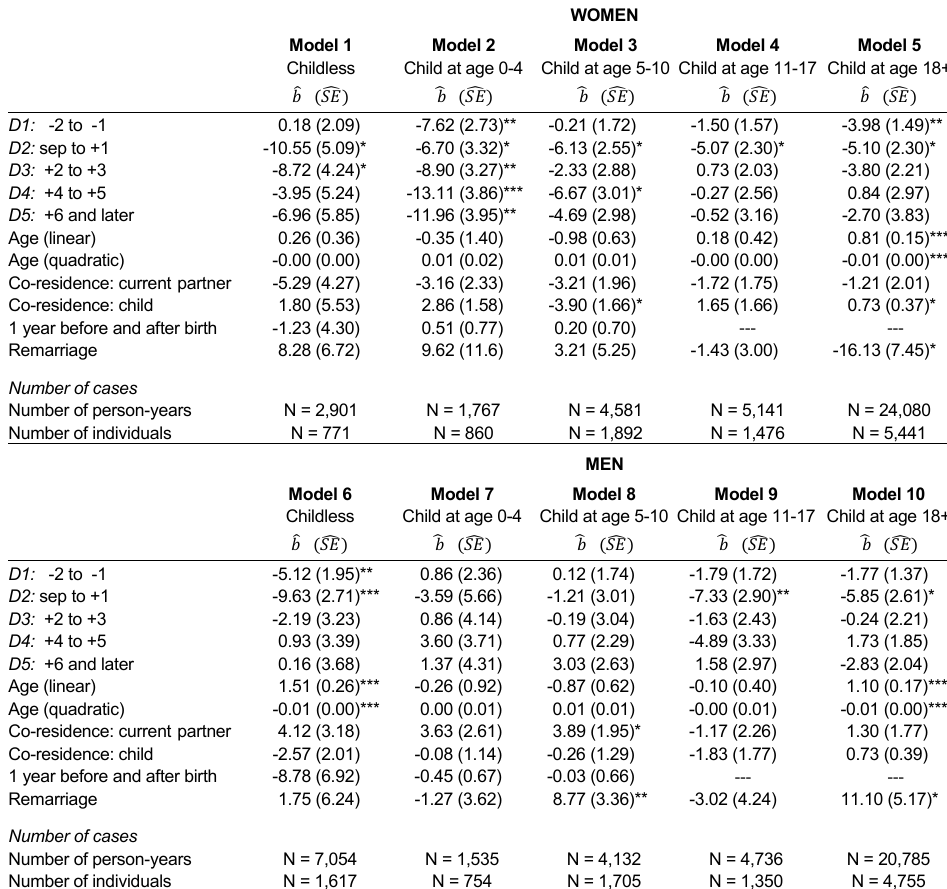
Distributed fixed-effects by age of the youngest child for men and women WOMEN Model 1 Model 2 Model 3 Childless Child at age 0-4 Child at age